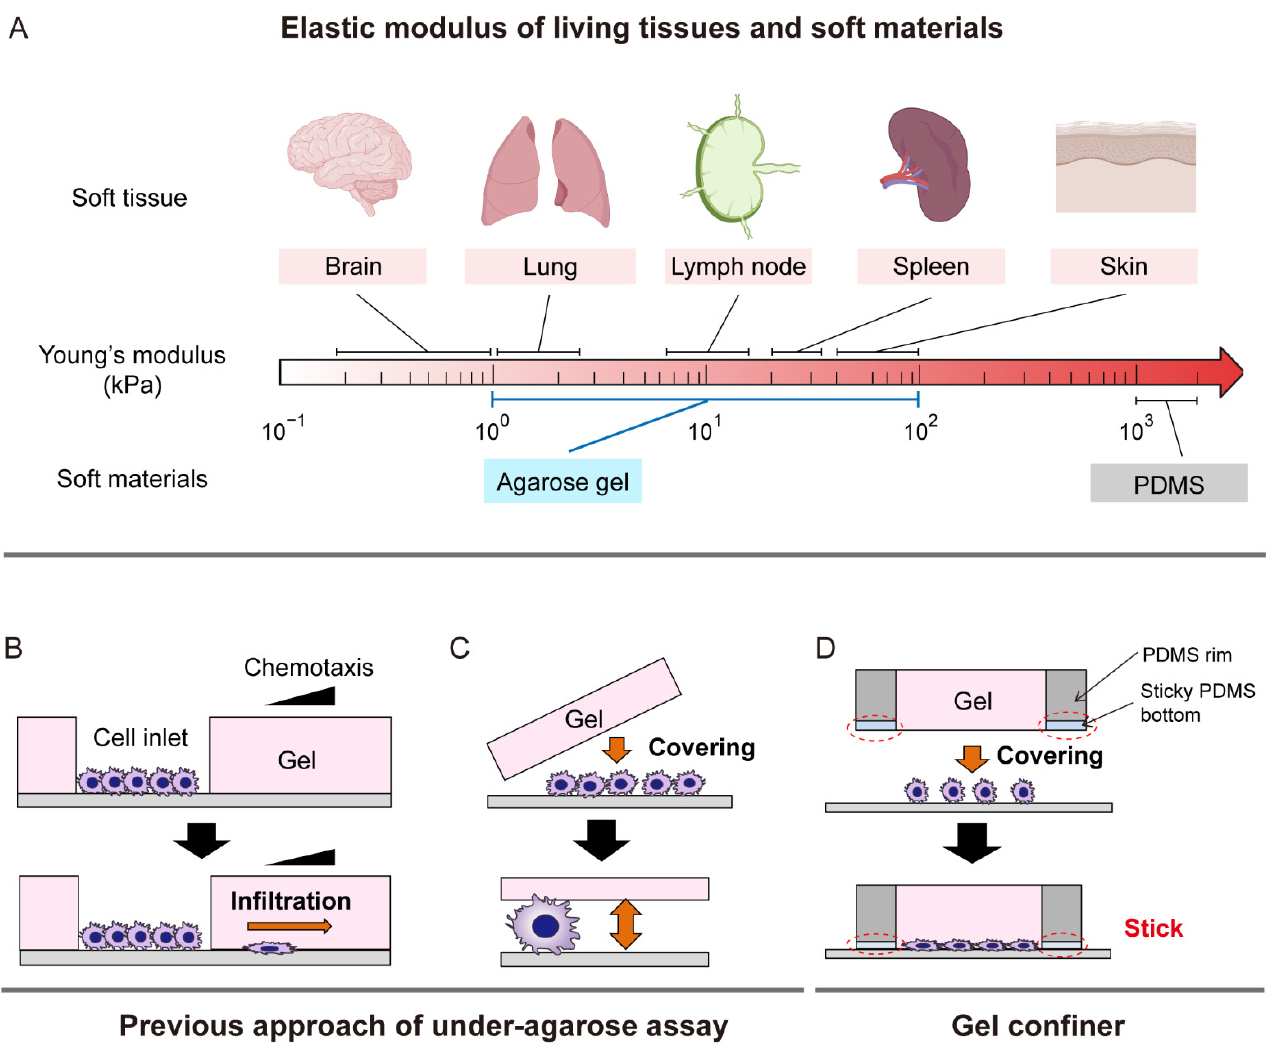
Figure 5. Experimental approaches to study cellular migration under confinement. ( A ) Elastic moduli of representative tissues in which DC motility has been intensively studied [21,22,35] . While DC motility has been intensively studied using PDMS microstructures, the elastic modulus of agarose gel better mimics these soft tissues. ( B ) Channel − like structures [36] and ( C ) bulk gel confinement [34] are under − agarose assay for studying amoeboid cell migration under confinement. ( D ) The gel confiner allows the handling of soft gels that better mimic confined in vivo environments [25] .